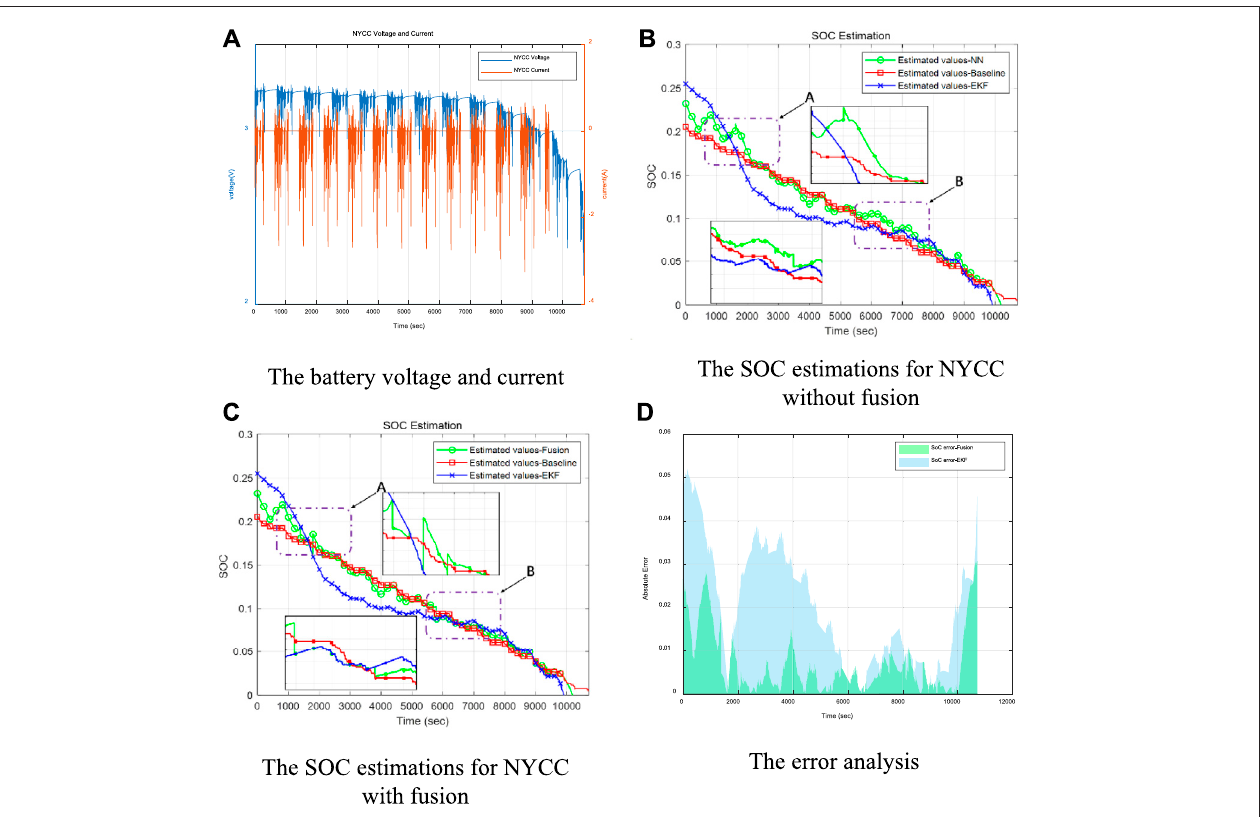
FIGURE13| TheevaluationresultsforlowbatterycapacityareaunderNYCC drivingcycle. (A) Thebatteryvoltageandcurrent (B) TheSOCestimationsforNYCC without fusion. (C) The SOC estimations for NYCC with fusion (D) The error analysis.